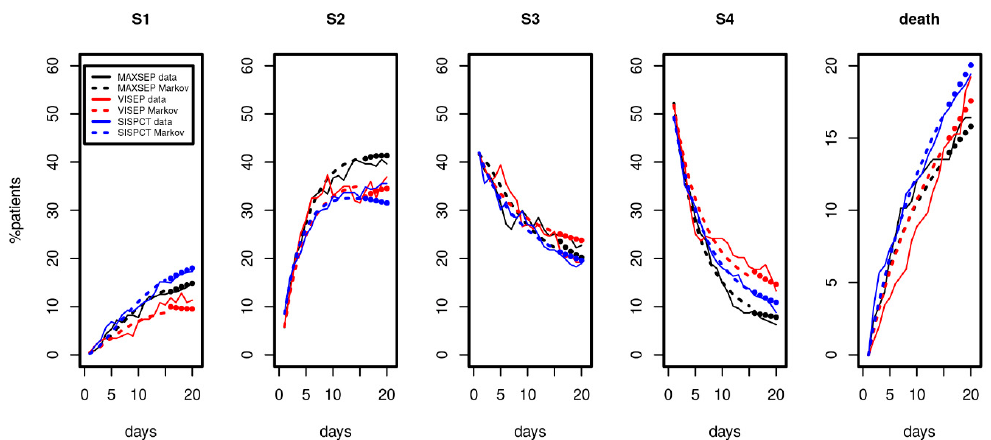
Figure 4. Results of Markov modelling (dashed curves) in comparison to data of the SepNet studies (solid curves) characterized by longer time series. Each panel shows the proportion of patients in the respective disease state over the first 15 days. The filled circles represent model predictions for days not included in model calibration. The data of the three studies fit well with the respective predictions of the Markov model.